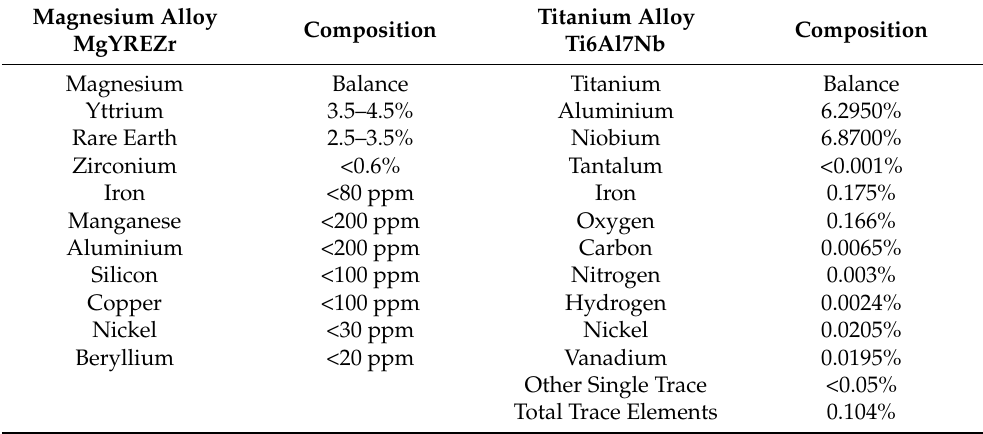
Table 2. Comparison of the materials in the screws in the test and reference groups.